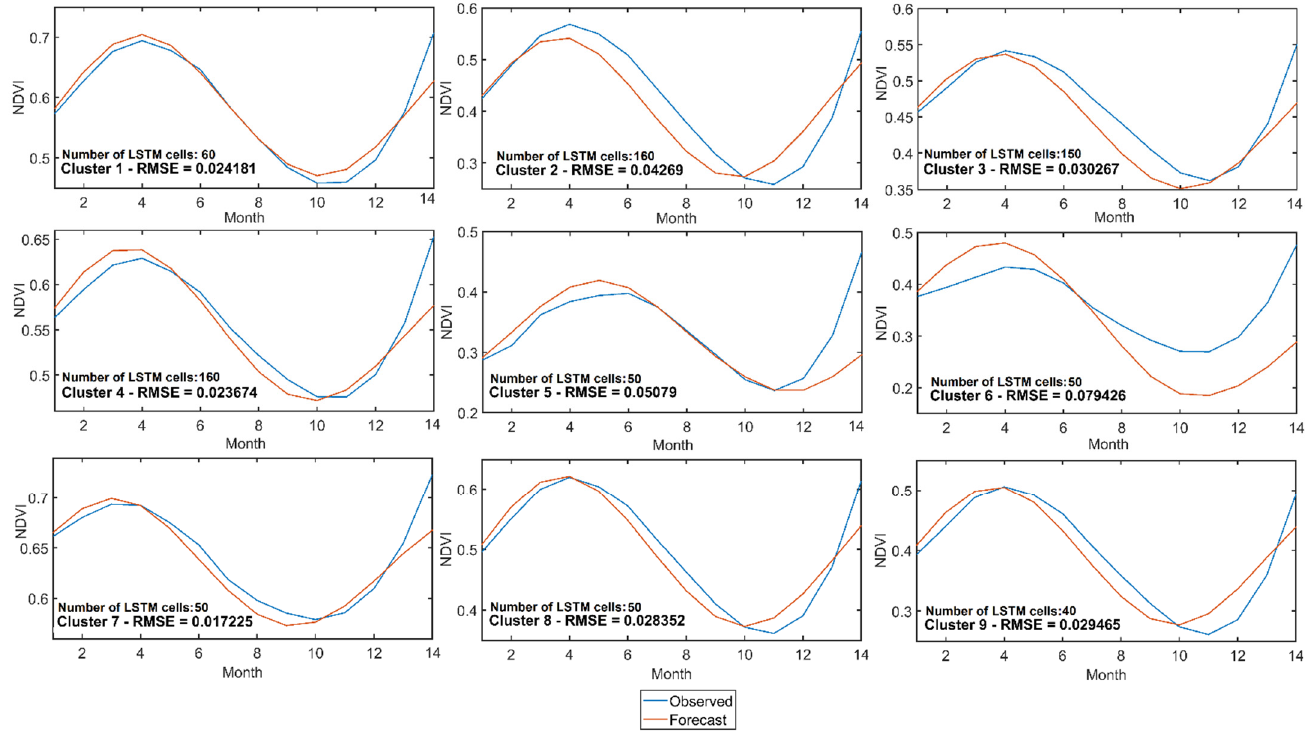
Figure 10. Observed versus forecasted NDVI of the testing dataset.